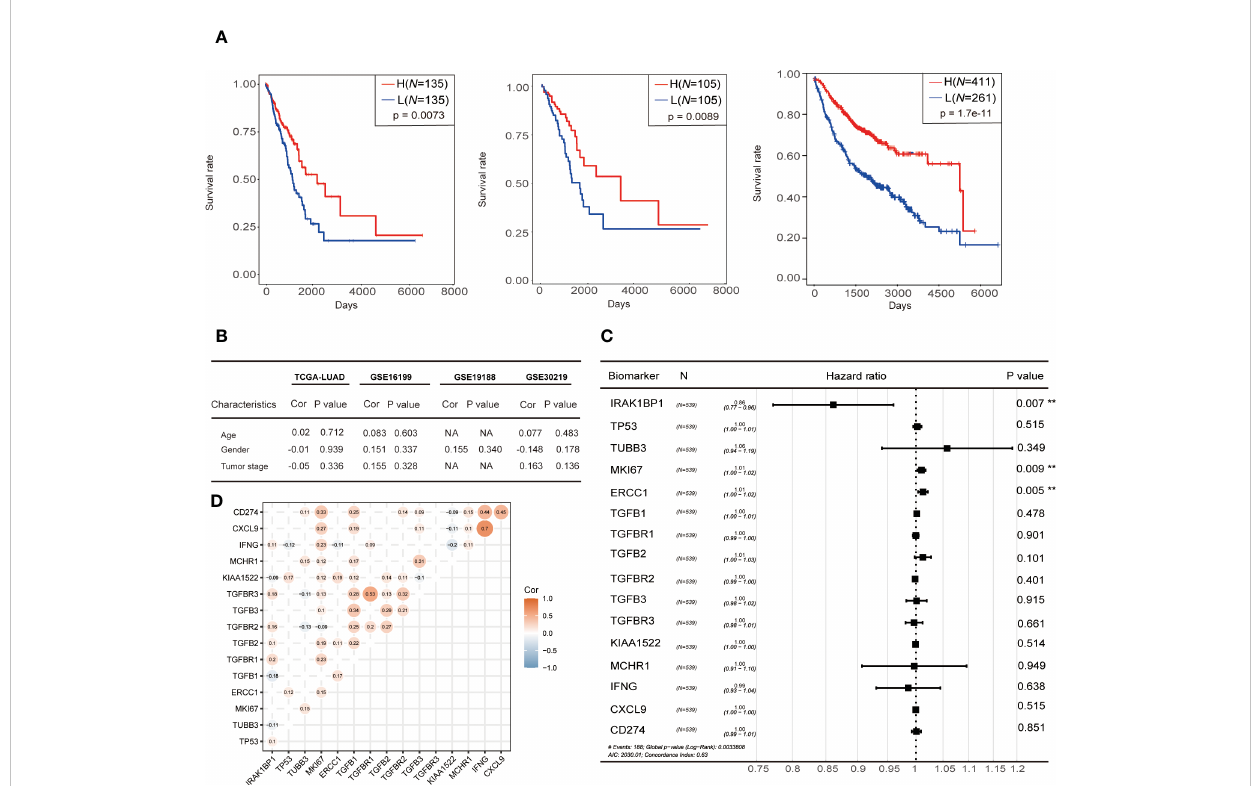
FIGURE 2 Correlation between IRAK1BP1 expression and prognosis. (A) The overall survival curve of IRAK1BP1 in total LUAD patients in the high-/low- expression group. Statistical signi fi cance of survival curves was assessed by a log-rank test. The overall survival curve of IRAK1BP1 in early stage (stage I and stage II) LUAD patients in the high-/low-expression group. Statistical signi fi cance of survival curves was assessed by a log-rank test. The overall survival curve of IRAK1BP1 in LUAD patients (CAARRY, GSE14814, GSE19188, GSE29013, GSE30219, GSE31210, GSE3141, GSE31908, GSE37745, GSE43580, GSE4573, GSE50081, GSE8894) in the high-/low-expression group. Statistical signi fi cance of survival curves was assessed by a log-rank test. (B) Correlation between the expression of IRAK1BP1 and patient age, gender, and tumor stage in TCGA-LUAD and 3 independent patient cohorts. (C) The Hazard ratio of reported novel prognostic biomarkers associated with lung cancer. Statistical signi fi cance of Hazard ratio was assessed by a log-rank test. (D) Correlation between the expression of IRAK1BP1 and the expression of genes in (C) . The P < 0.05 was discarded between two